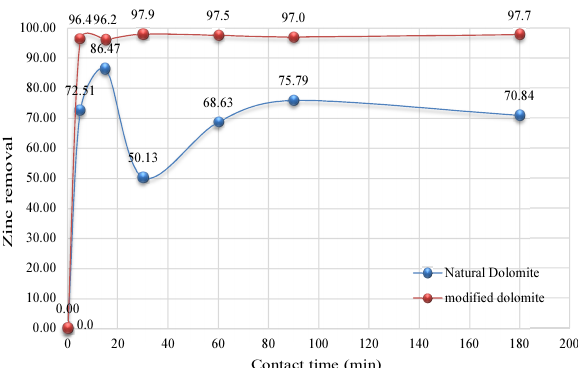
Fig. 1. Comparison of removal efficiency of zinc (%) from solution (5 mg/l) by natural dolomite and modified dolomite (1 g) within specified contact